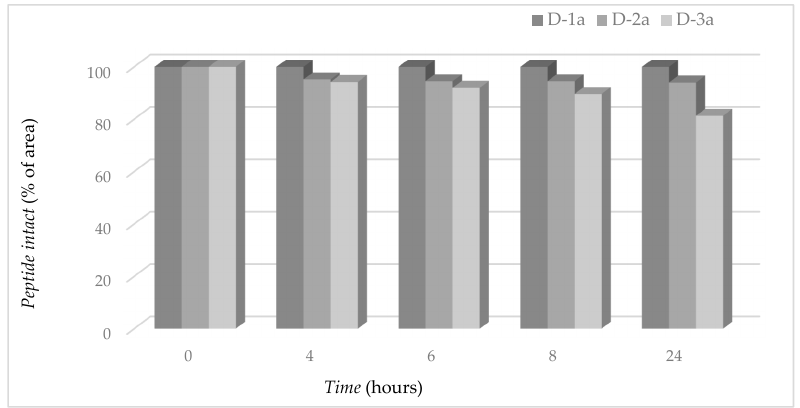
Figure 14. Proteolytic stability of ferrocene peptides during 24 h.